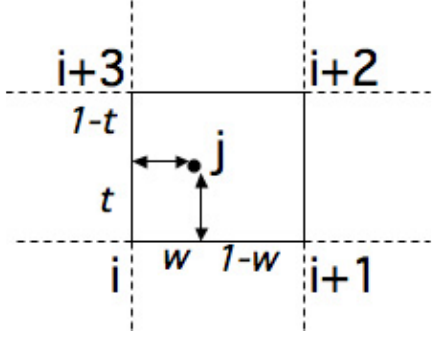
Fig. 3. The H operator. i , i + 1, i + 2 and i + 3 are the grid points surrounding the station j . The weights w and t are the distances between the station j and grid point i along the x and y directions of the polar stereographic projection used by RAMS.